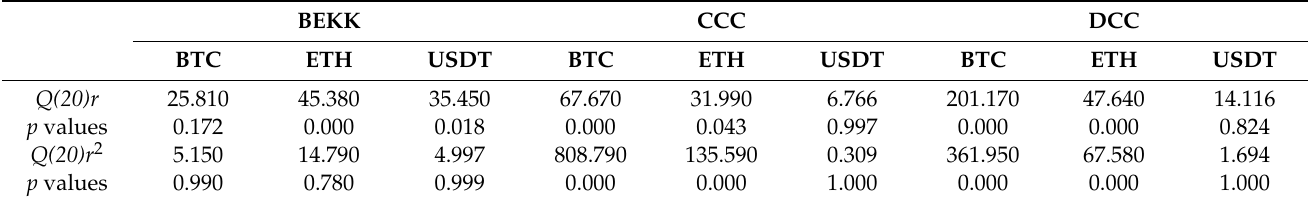
Table 5. Diagnostic tests for standardised